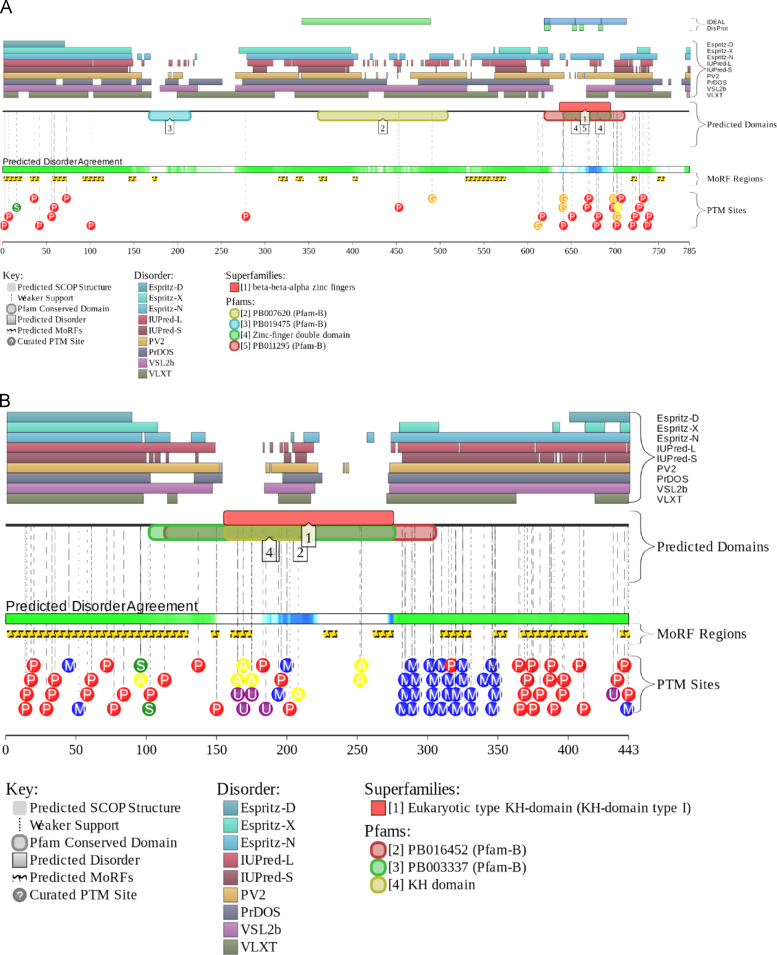
Evaluation of the functional intrinsic disorder propensity of representative human nuclear proteins by D2P2 database (http://d2p2.pro/) [19]. (A) Sp1 (UniProt ID: P08047). (B) Sam68 (UniProt ID: Q07666). (C) CASC3 (UniProt ID: O15234). (D) Coilin (UniProt ID: P38432). (E) SRA1p (UniProt ID: Q9HD15). (F) SMN (UniProt ID: Q16637).